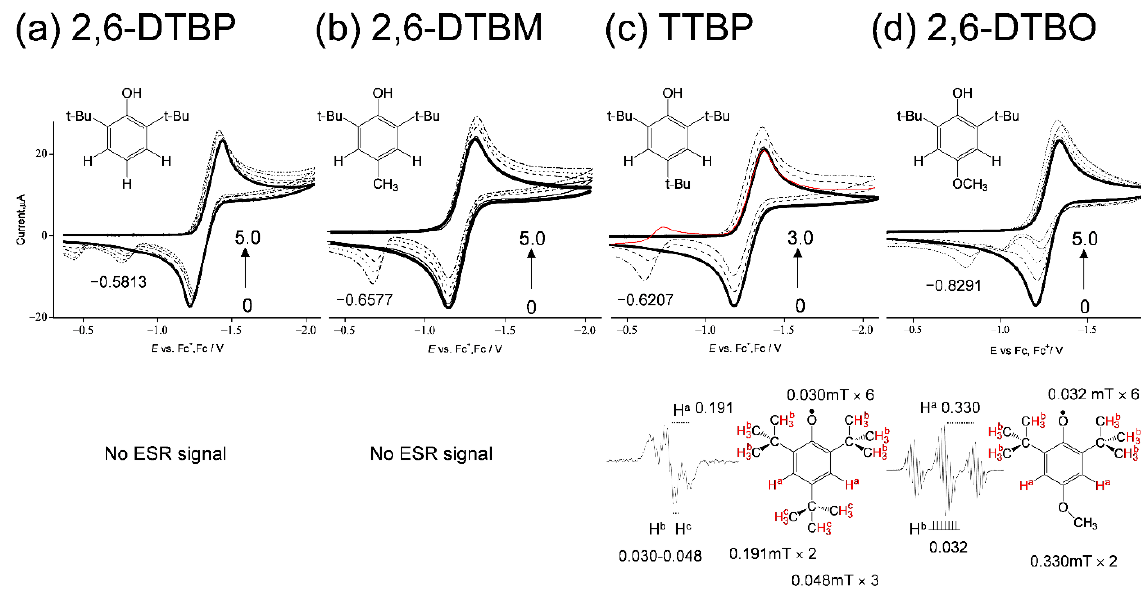
Figure 8. CVs of 4.8 × 10 −3 mol dm −3 O 2 in the presence of ( a ) 2,6-DTBP, ( b ) 2,6-DTBM, ( c ) TTBP, and ( d ) 2,6-DTBO in DMF containing 0.1 mol dm −3 TPAP. The concentrations (×10 −3 mol dm −3 ) are 0 (bold and ( d ) 2,6-DTBO in DMF containing 0.1 mol dm − 3 TPAP. The concentrations ( × 10 − 3 mol dm − 3 ) are 0 (bold line), 1.0, 3.0, and 5.0 ( a , b , d ), and 0 (bold line), 1.0, and 3.0 ( c ) (the concentration changes